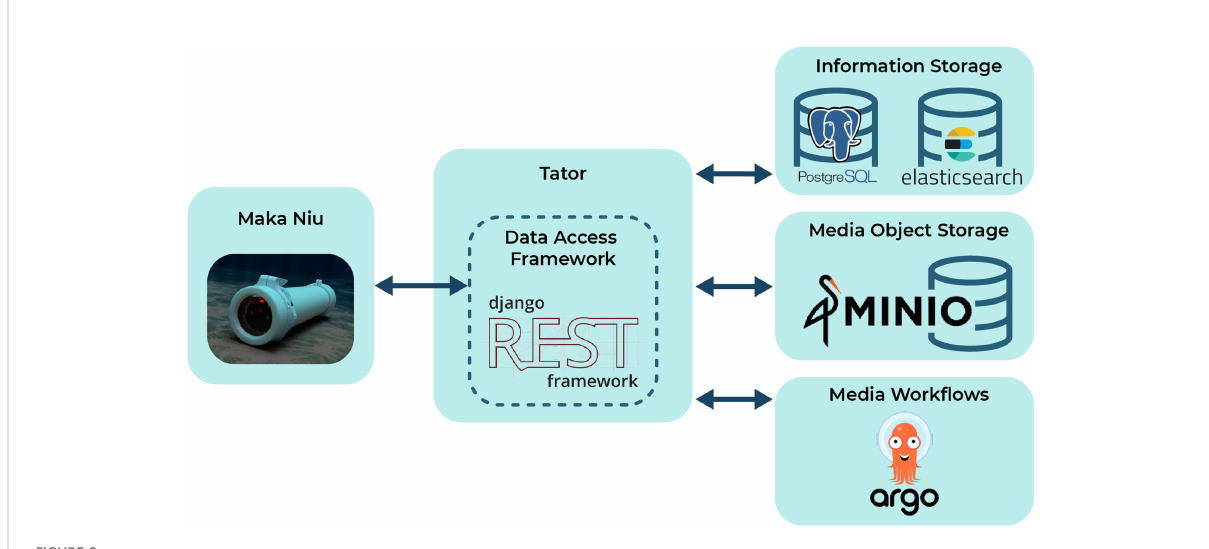
FIGURE 8 The Tator data ingestion pipeline and media management work fl